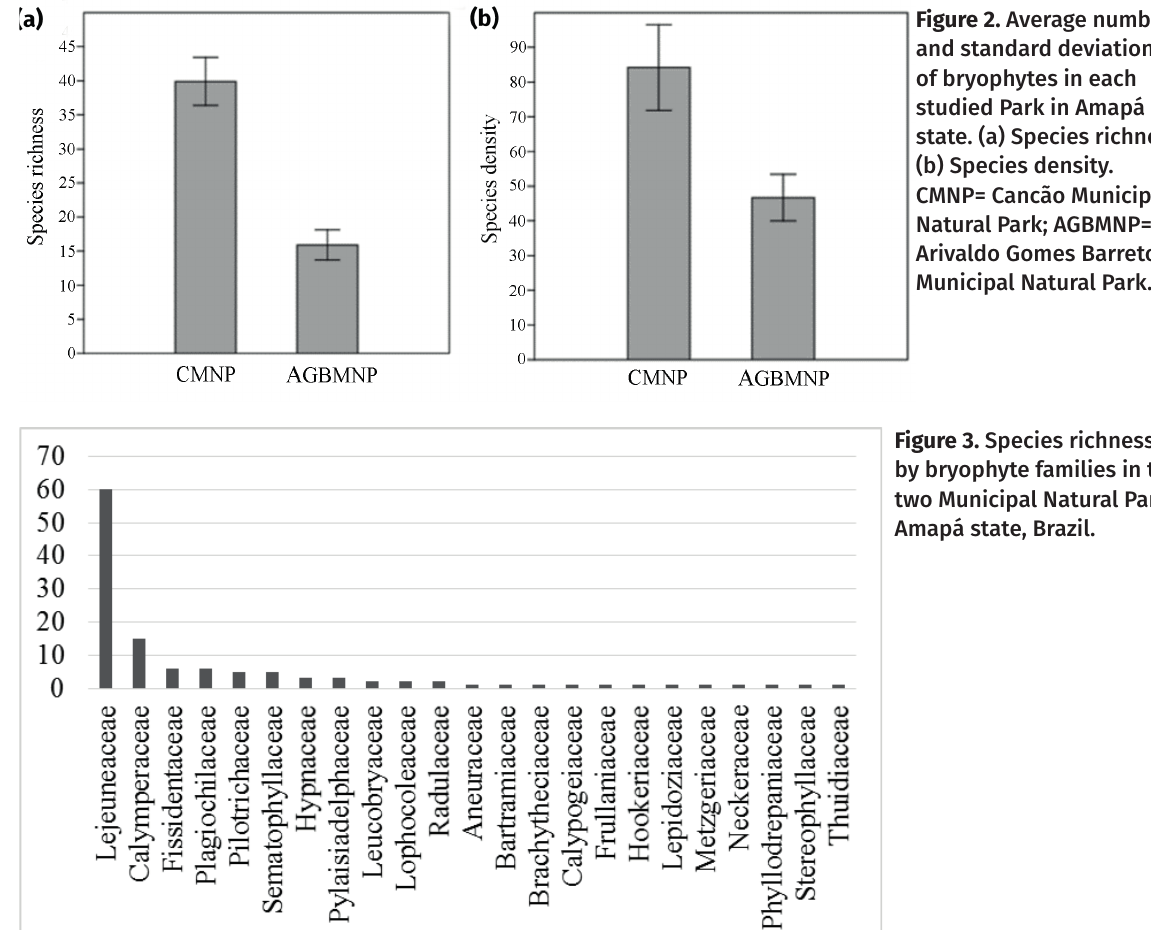
Figure 3. Species richness by bryophyte families in the two Municipal Natural Parks, Amapá state,